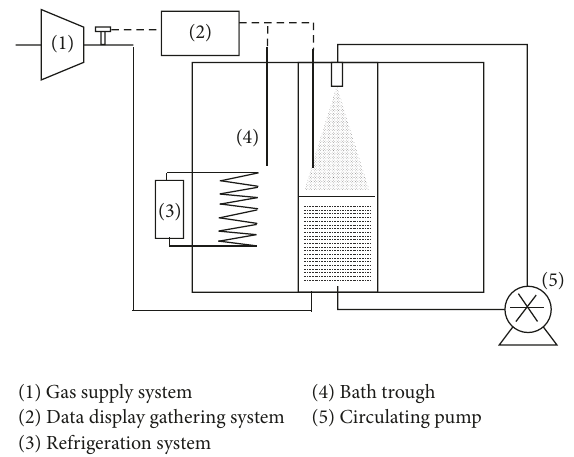
Figure 1: Schematic diagram of forming hydrates in spray